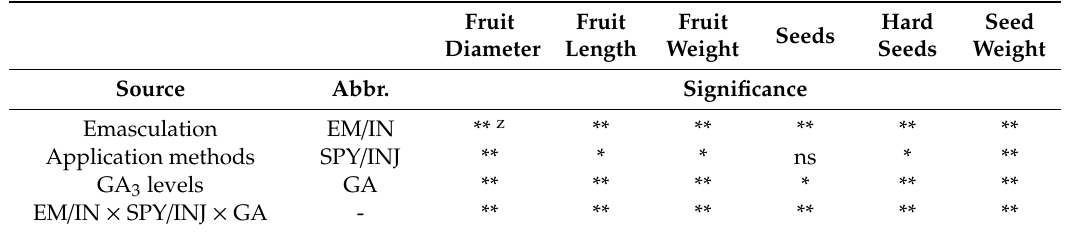
Table 4. ANOVA significance results of the single and combined e ff ects on fruit and seed dimensions. Hard Seed Fruit Fruit Fruit Seeds Seeds Weight Diameter Length Weight Source Abbr. Significance Emasculation EM / IN ** z ** ** ** ** ** Application methods SPY / INJ ** * * ns * ** GA 3 levels GA ** ** ** * ** ** EM / IN × SPY / INJ × GA - ** ** ** ** **